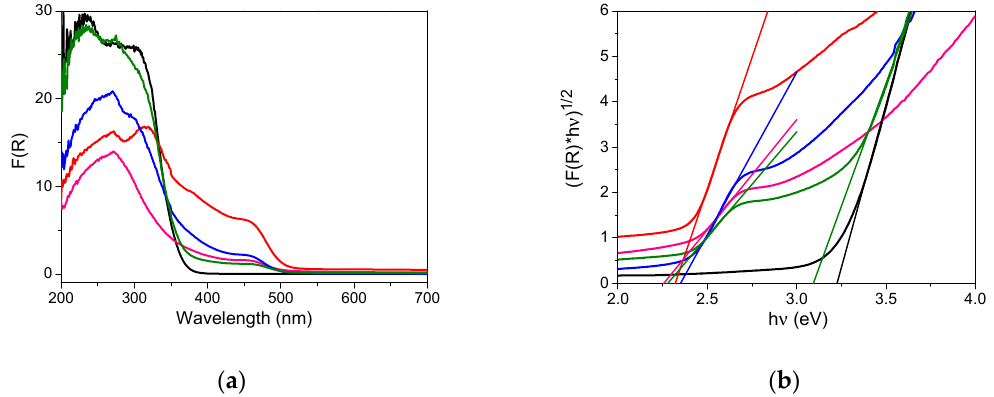
Figure 3. Kubelka–Munk di ff usion reflectance UV–visible spectra ( a ) and Tauc plots for indirect band-gap determination ( b ) of the synthesized Ag 3 PO 4 -based catalysts and the commercial TiO 2 : cubes (red), rhombic dodecahedrons (blue), spheres (pink), hybrid Ag 3 PO 4 –TiO 2 (green), and TiO 2 (black). Linear fittings to estimate the band-gaps are shown.